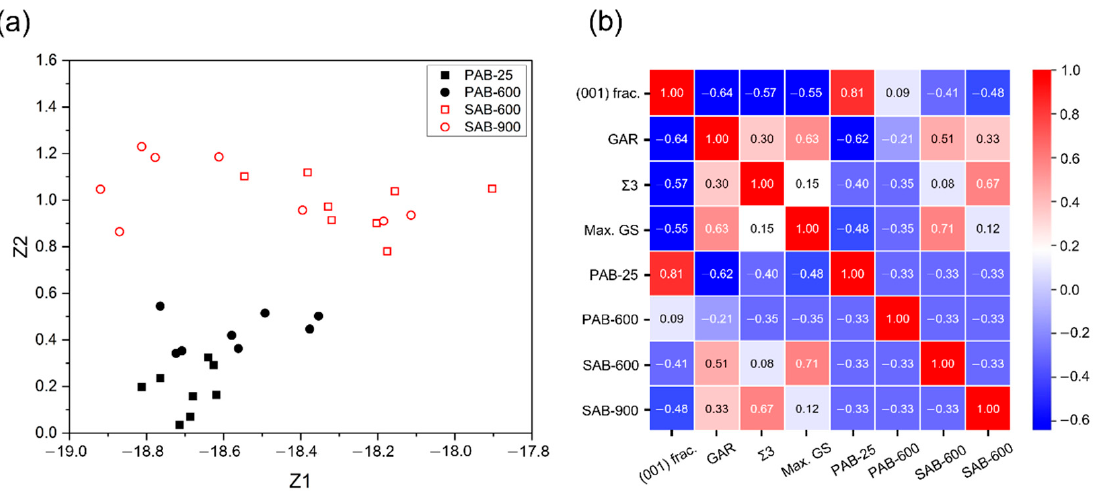
Figure 13. Machine-learning analyses of primary-arc beads (PABs) and secondary-arc beads (SABs): ( a ) t-SNE plot and ( b ) Pearson correlation analysis.